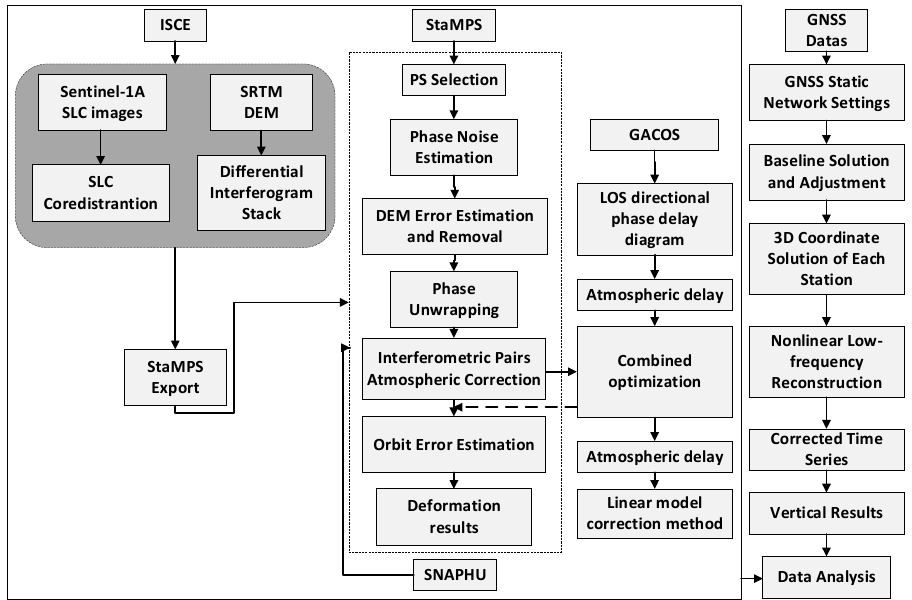
Figure 1. Data processing flow